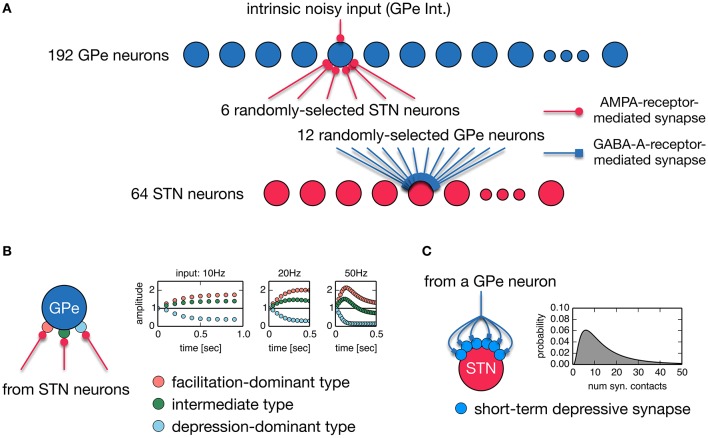
(A) A random, sparsely-connected architecture of the recurrent circuit model between the STN and GPe. (B) Properties of three different types of short-term plasticity at STN-GPe synapses. A type of short-term plasticity is randomly chosen for a STN-GPe synapse with equal probability from these three types regardless of a post-synaptic neuron. (C) A single GPe axon gives multiple synaptic contacts on a STN neuron. Transmission probability of a unitary GPe projection is dynamically modulated by short-term depression. The number of synaptic contacts that a single GPe axon established on an STN neuron obeys the log-normal distribution.